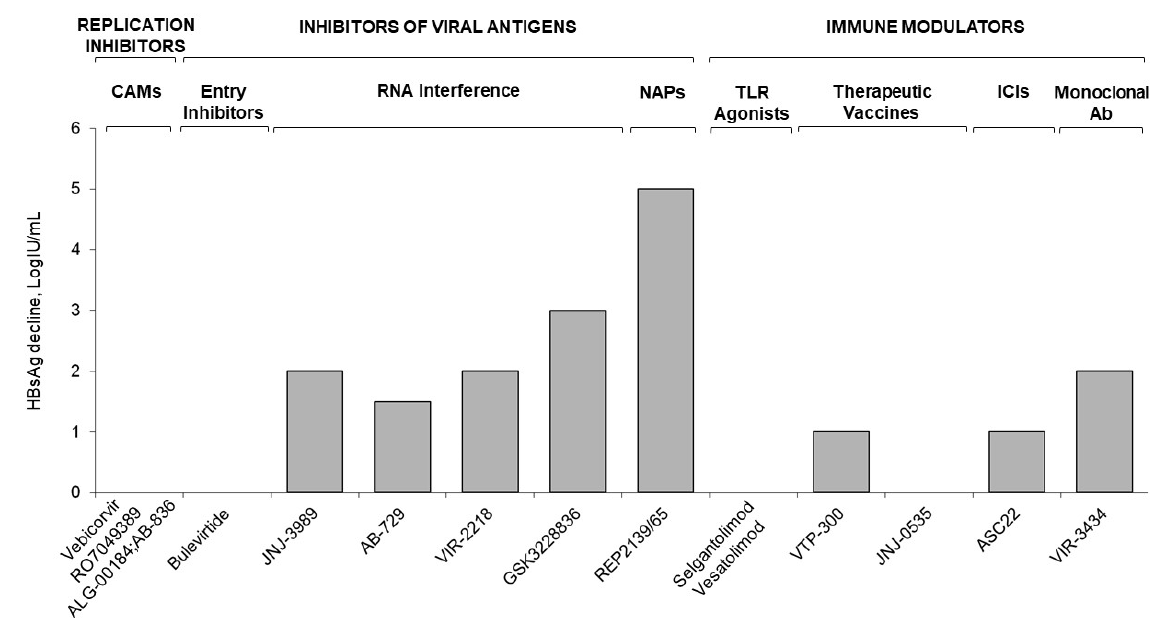
Figure 2. End-of-treatment median HBsAg decline across the main investigational HBV agents.